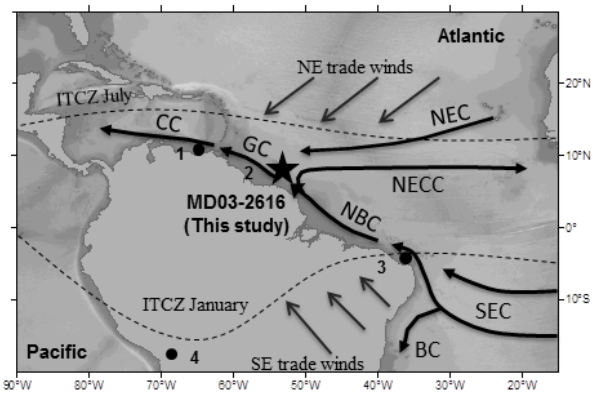
Figure 1. Map showing the sites mentioned in the text: (1) ODP 1002 (Peterson et al., 2000), (2) MD03-2616, this study (7.4875 ◦ N, 53.0080 ◦ W; − 1233 metres below sea level), (3) GeoB- 3910 (Jaeschke et al., 2007, (4) Sajama ice core; Thompson et al., 1998). Guiana current (GC), north equatorial current (NEC), Caribbean current (CC), north Brazil current (NBC), north equa- torial countercurrent (NECC), south equatorial current (SEC) and Brazil current (BC). ITCZ and trade winds are shown (humid north- easterlies when the ITCZ moves north of the equator and dry south- easterlies when it moves